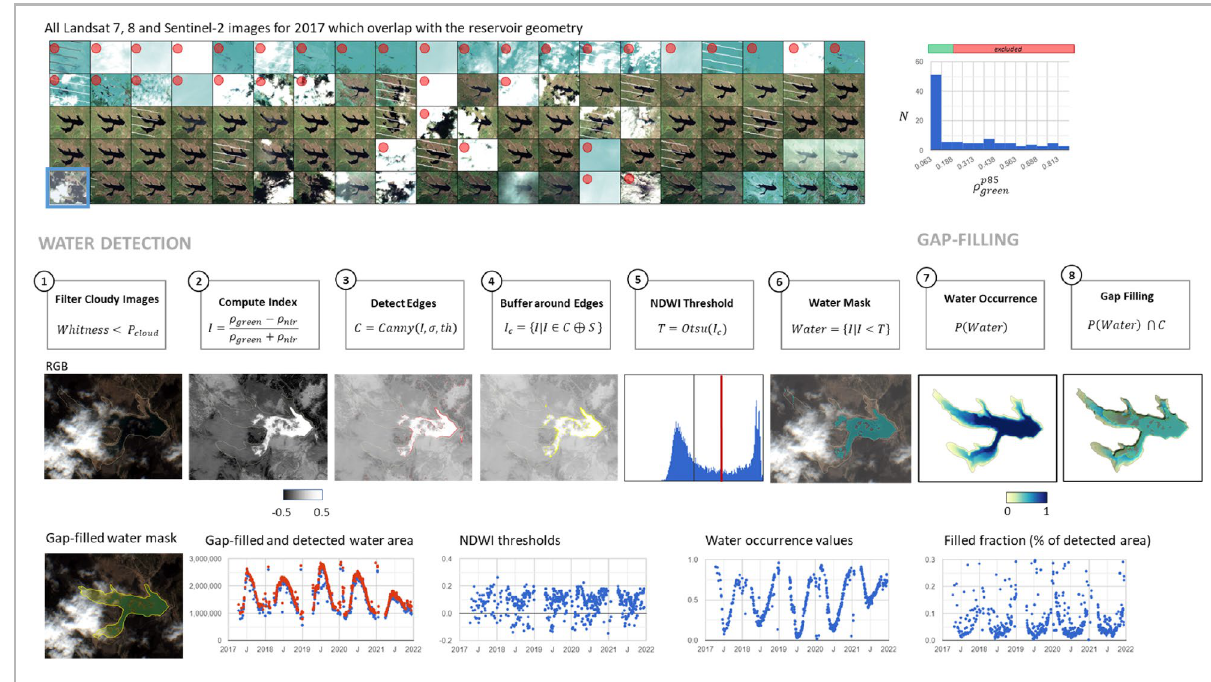
Figure 6. Method of surface water area detection for reservoirs. The algorithm to compute surface water consists of the next steps: (1) Select satellite images least cloudy over the reservoir area (2) Compute spectral water index (NDWI here, but could be any spectral index suitable for surface water detection) (3) Apply Canny edge filter to detect water/land edges (additional steps can include edge suppression based on the spectral properties around edges) (4) Define sampling region for pixels surrounding water/land edges (5) Sample spectral index values within the buffer computed during step 4 and compute optimal threshold using Otsu method used to (6) Compute the surface water area (7) Select surface water occurrence (8) Fill gaps (false- negatives) in the resulting water mask, remove incorrectly detected water (false-positives) by sampling water occurrence along water edges, and compute the final filled surface water area mask by clipping water occurrence at a given probability and combining it with the detected water mask. The figure was generated using Google Earth Engine Code Editor tool 14 . Code: https:// code. earth engine. google. com/ 54602 c8309 f44cf 83e42 cf93a 854dc